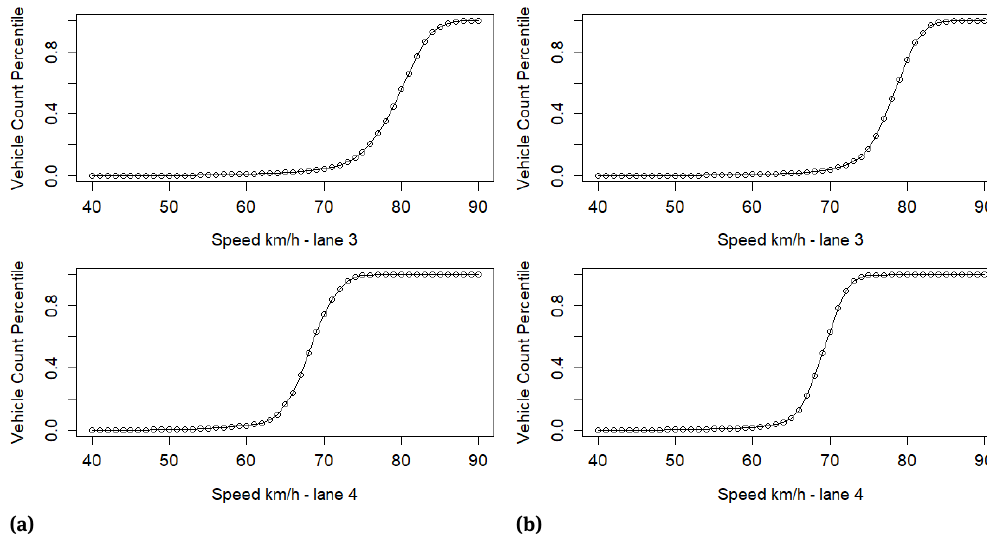
Figure 8: Annual hourly traflc cumulative speed distribution curve on lanes 3 and 4 a) in 2012 b) in